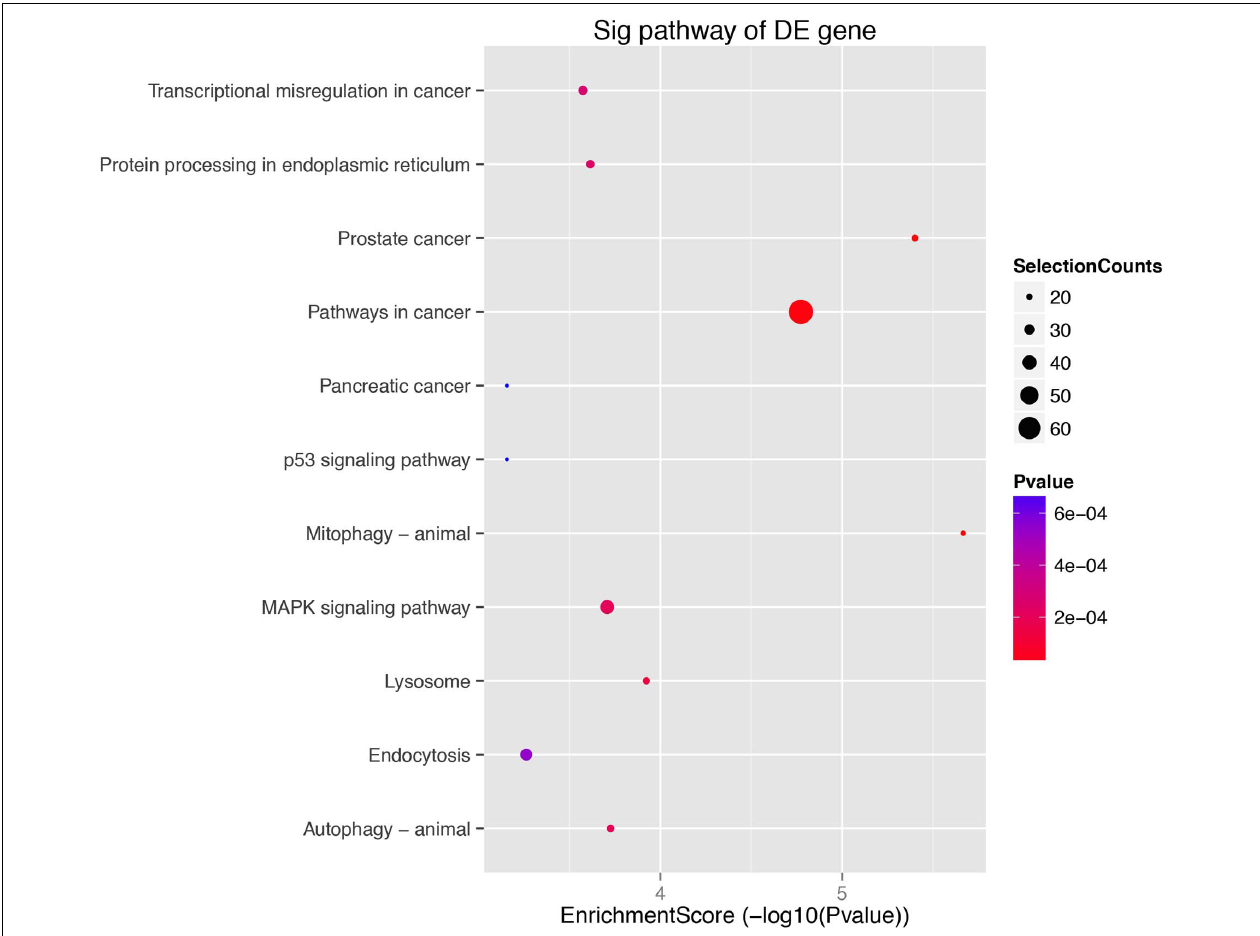
FIGURE 6 | KEGG analysis. KEGG pathway analysis was used to determine the involvement of mRNAs in different biological pathways. The size of each circle indicates the number of circRNAs. The color of the circle indicates the P -value. The larger the circle and the lower the P -value, indicating a richer and more meaningful